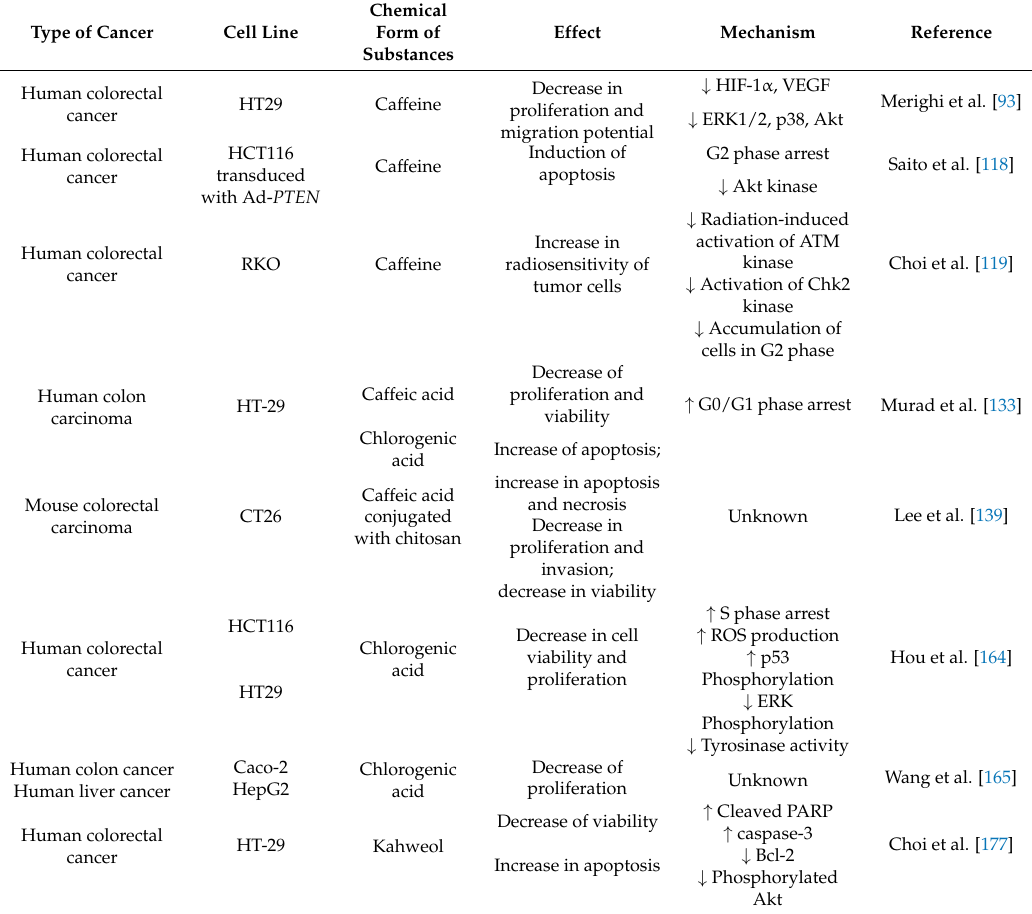
Potential mechanisms of caffeine, caffeic acid, chlorogenic acids, and kahweol on antitumor